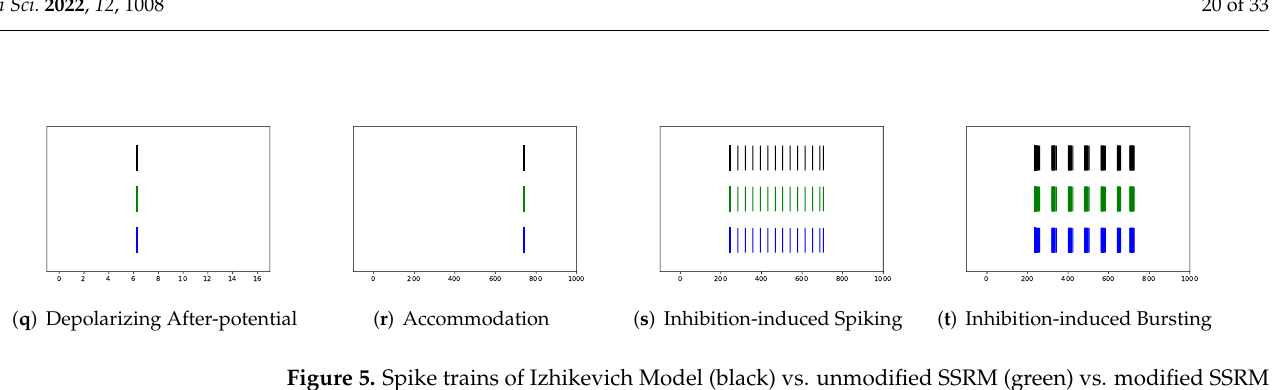
Figure 5. Spike trains of Izhikevich Model (black) vs. unmodified SSRM (green) vs. modified SSRM by maximum tolerance (blue), where x-axis is the time